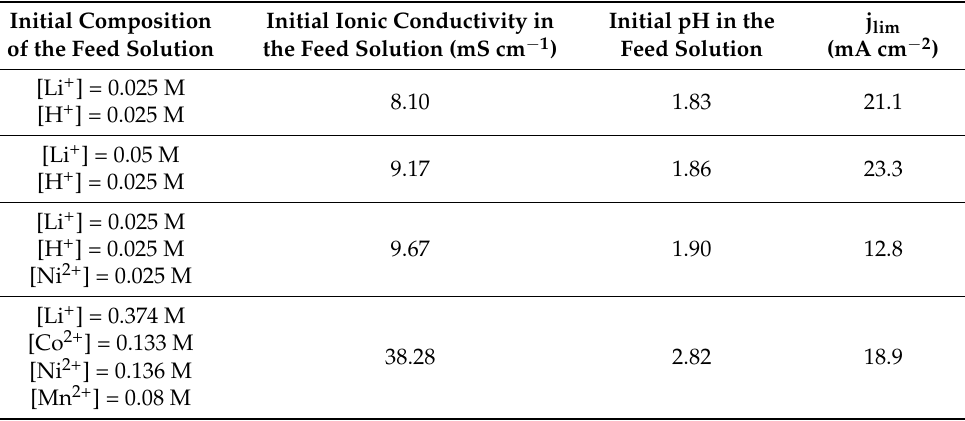
Table 3. Limiting current density (j lim ) determined by the Cowan and Brown method (Cowan